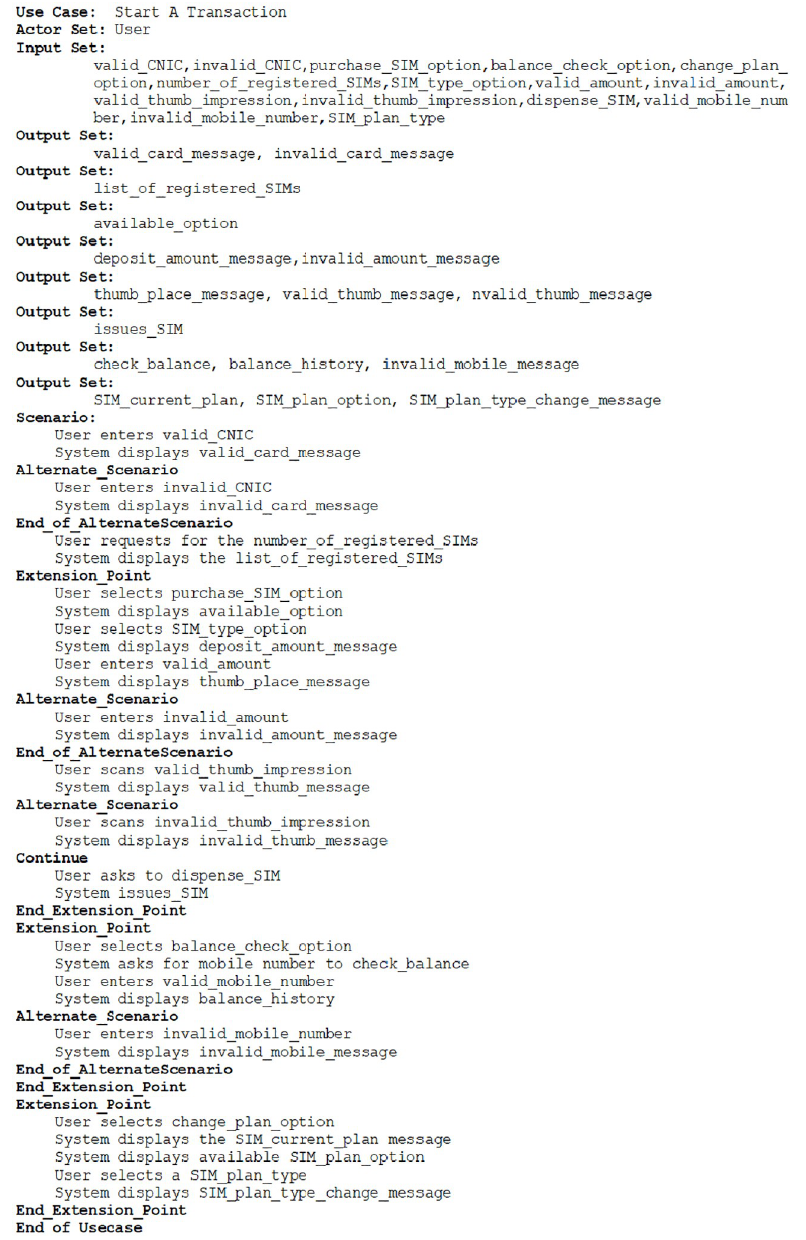
Fig 10. A SIM vending machine start a transaction use case detailed